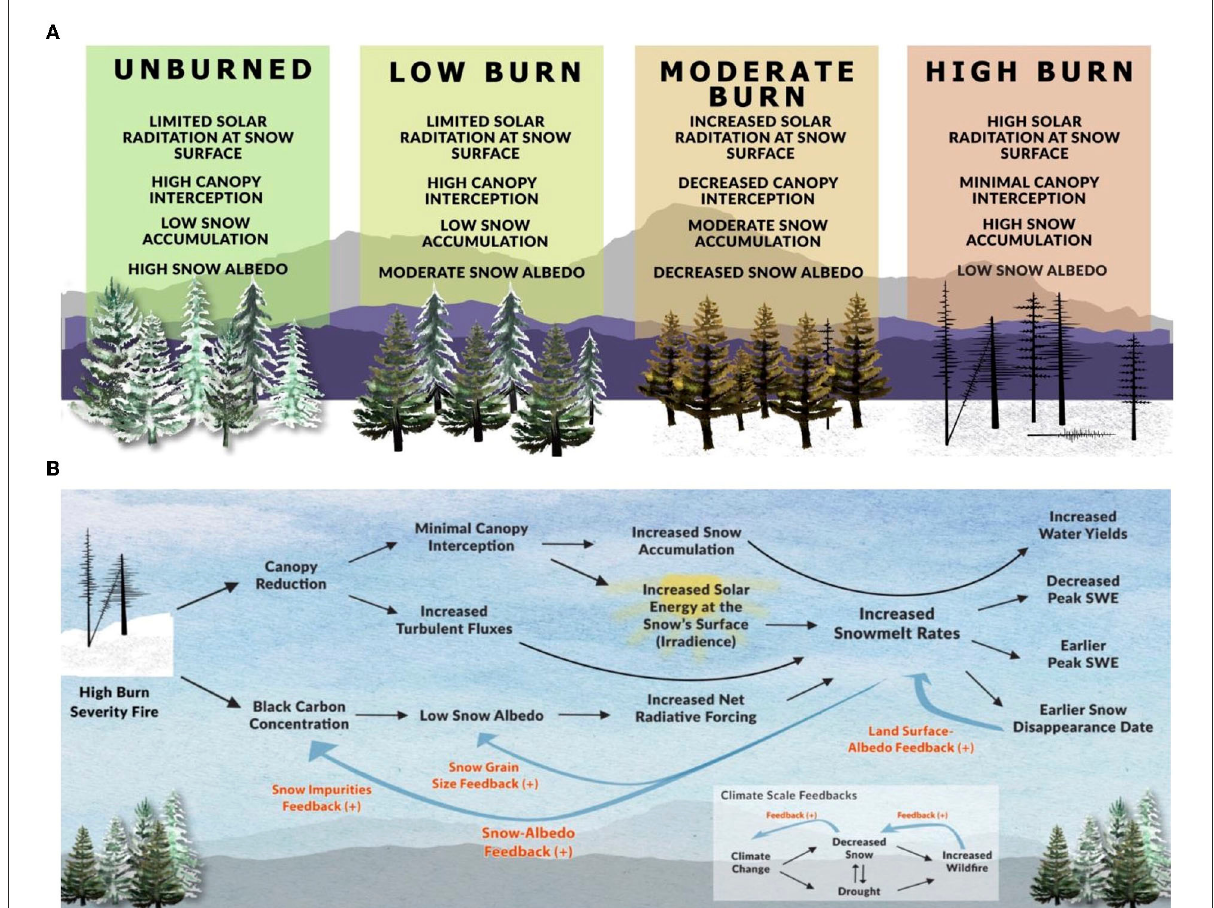
FIGURE1 (A) Schematic drawing of changes in snow processes during melt season after a fire for each burn severity. Changes in solar radiation, canopy interception, snow accumulation and snow albedo are noted above. (B) Diagram of post-wildfire effects on snow processes. Existing feedbacks are noted by blue arrows. Climate scale feedbacks are noted in the smaller box on the